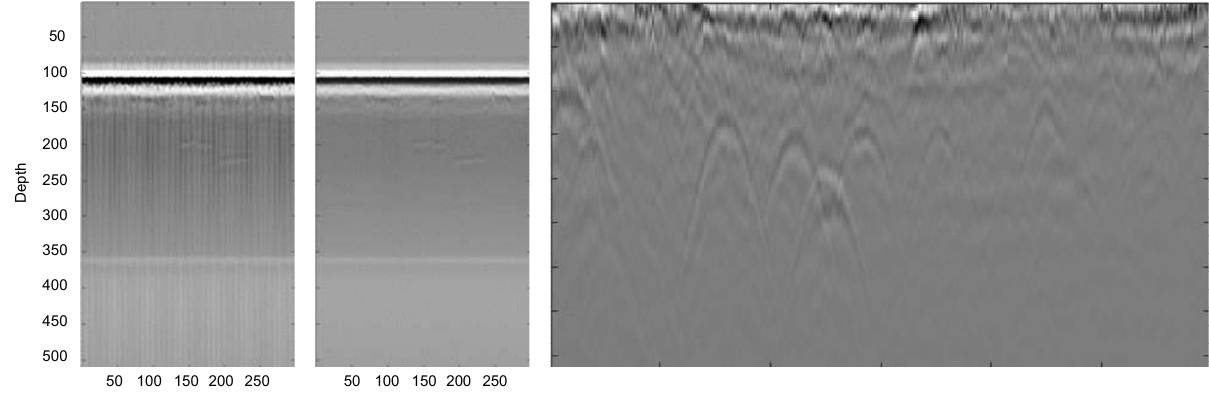
Figure 6 . Resulting GPR data after pre-processing: exemplary B-Scan.